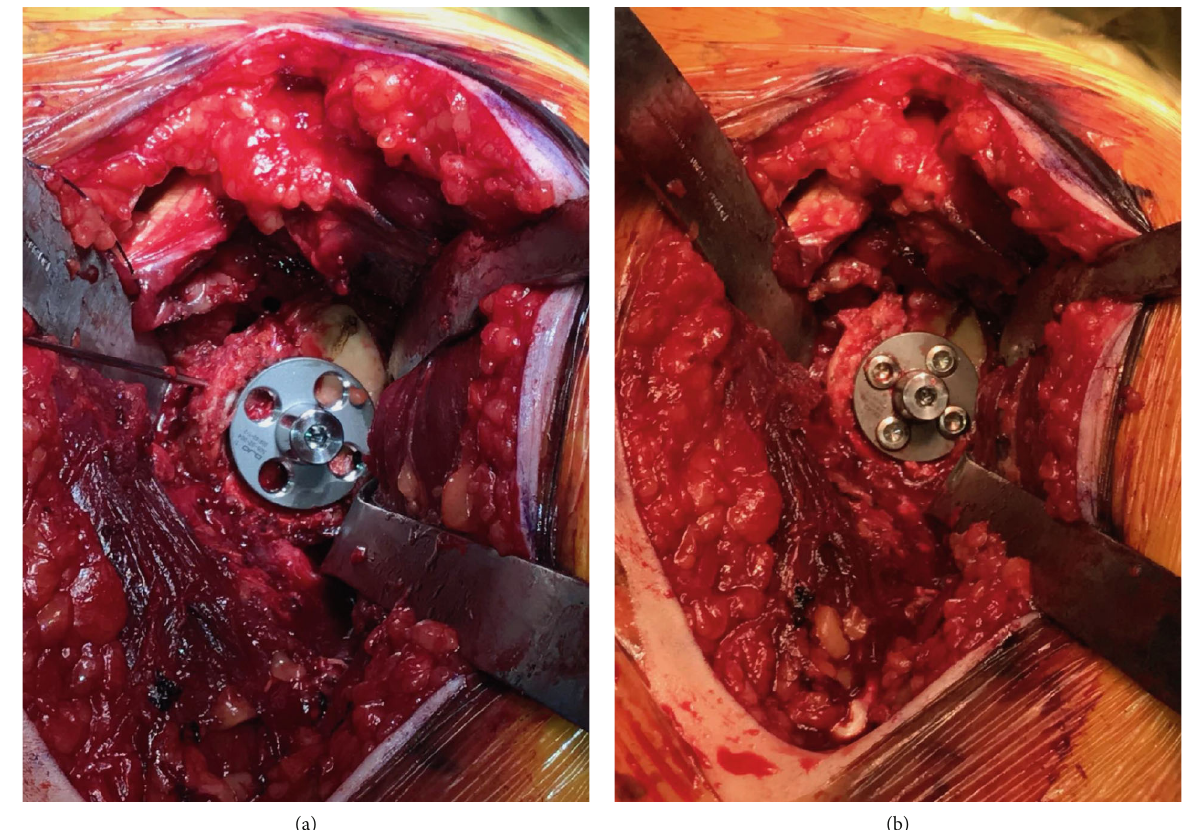
Figure 3: Clinical photos demonstrating provisional fi xation with K-wires (a) and de fi nitive fi xation with compression of fracture fragments through the glenoid baseplate (b).